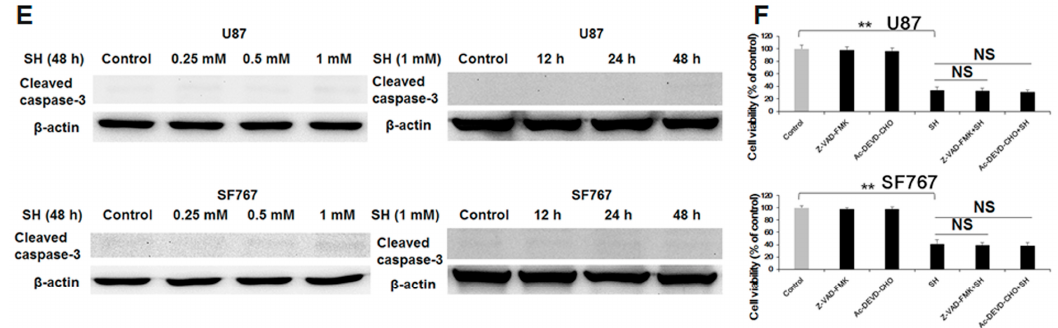
Figure 1. SH inhibits cell proliferation through a caspase-independent pathway in U87 and SF767 cells. ( A ) Dose- and time-dependent effects of SH on cell viability. U87 and SF767 cells were treated with different concentrations of SH (0.0625, 0.125, 0.25, 0.5, 1 mM) for 24, 48 or 72 h, and cell viability was assessed via cell counting kit-8 (CCK-8) assays; ( B ) The cells were treated with 0.125, 0.25, 0.5, or 1 mM SH for 48 h, and LDH assays were performed; ( C ) U87 and SF767 cells viability upon the indicated concentrations of SH treatment was measured via colony formation assays; ( D ) Dose-dependent effects of SH on apoptosis. After treatment with the indicated concentrations of SH for 48 h, apoptosis was detected through Annexin V-FITC/PI staining and quantitative analysis of the percentage of Annexin V-positive and PI-negative cells compared with the control groups; ( E ) Extent of apoptosis, as observed by the levels of cleaved caspase-3 in U87 and SF767 cells, in the two cell lines treated with the indicated concentrations of SH for 48 h or at 1 mM for the indicated times; ( F ) Effects of the caspase-3 inhibitor Ac-DEVD-CHO and the pancaspase inhibitor Z-VAD-FMK on human glioblastoma cell death induced by SH. U87 and SF767 cells were preincubated with Z-VAD-FMK (50 µ M) and Ac-DEVD-CHO (50 µ M) for 1 h, followed by co-incubation with SH (1 mM) for 48 h. Each image is representative of n = 3 experiments. The results shown in E are one representative Western blot, n = 3, and β -actin served as the loading control. All data are shown as the mean ± SEM, n = 3. * p < 0.05, ** p < 0.01, versus the control. NS, not significant versus the control or SH treatment alone.